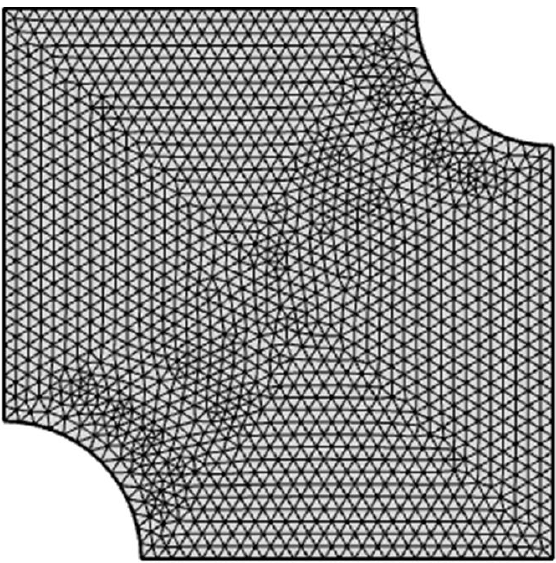
Figure 2. Meshing of the nanofluid domain .